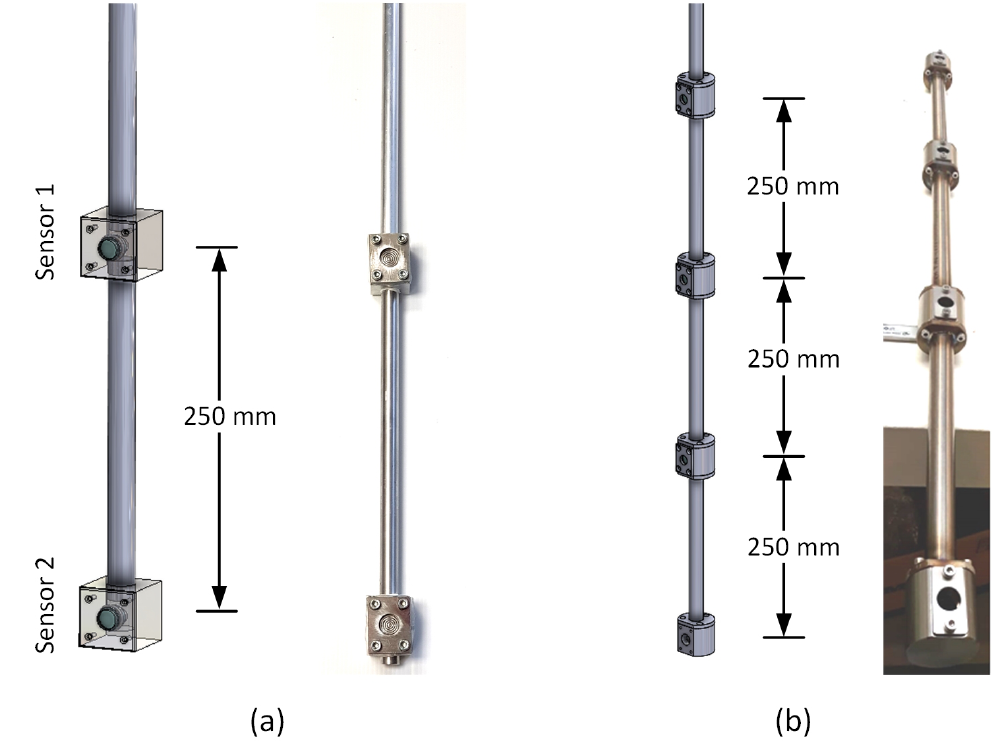
Figure 2. Brix sensor design: ( a ) consisting of two pressure sensors for sugar monitoring and ( b ) consisting of four pressure sensors for fermentation monitoring.